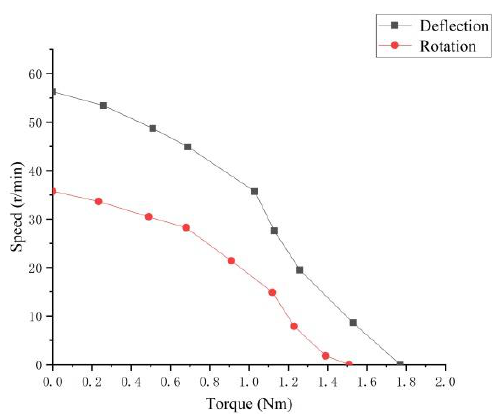
Figure 18. Torque-speed under 150 N preload.